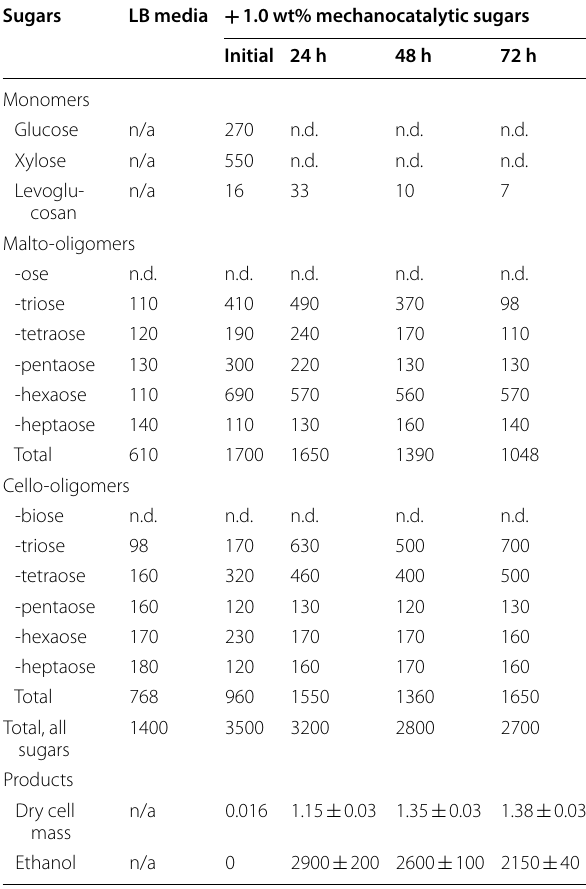
Table 1 Concentration (mg/L) of the major media components